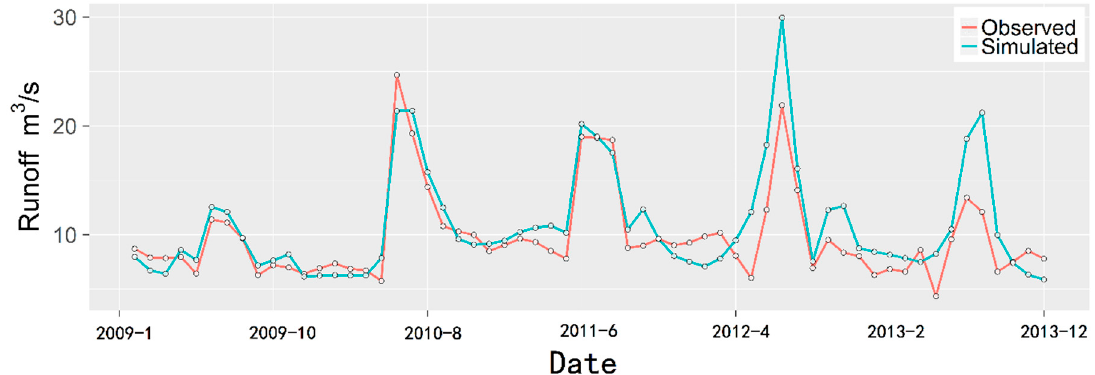
Figure 5. Monthly runoff (2009–2013) of Hot Spring station derived from the SWAT model driven by the CMADS.